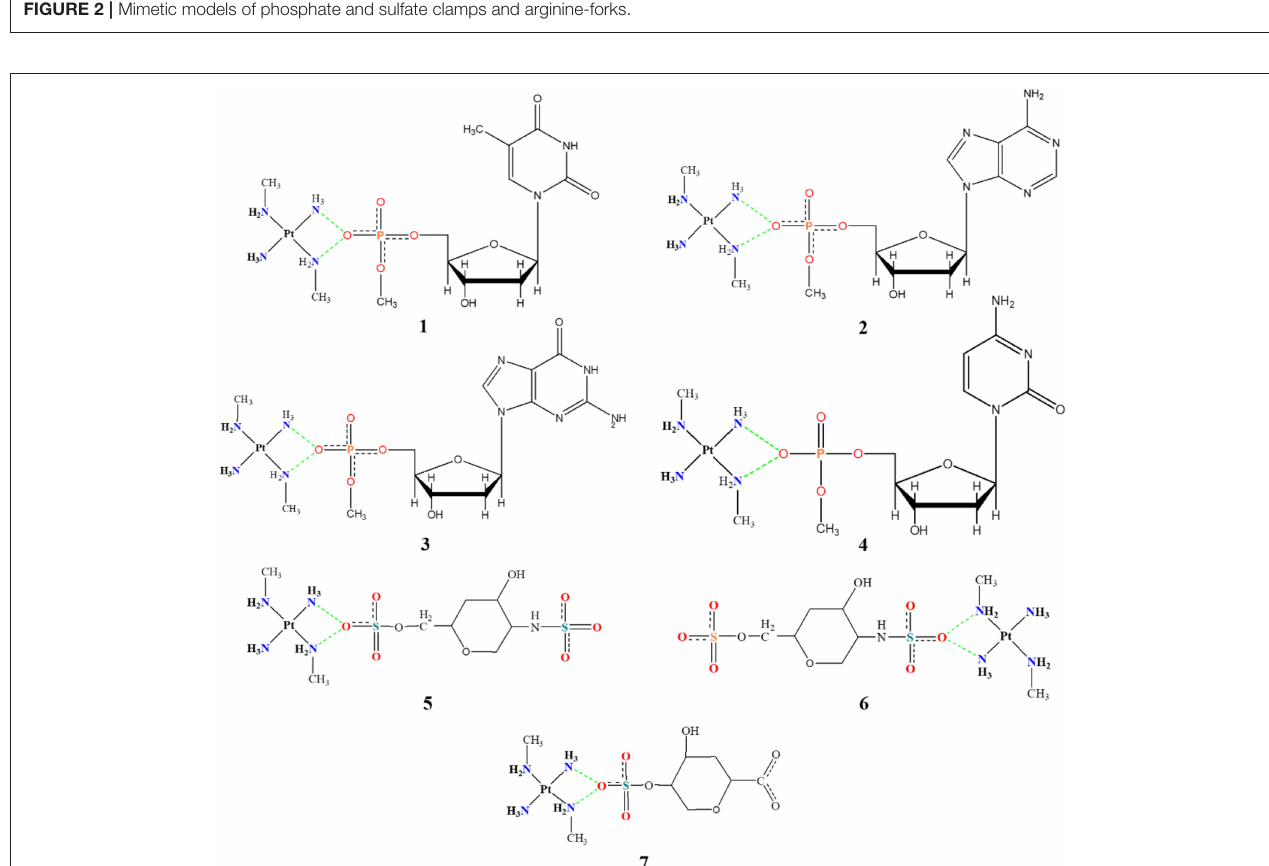
FIGURE 3 | Mimetic models based on nitrogenous bases and fractions of the disaccharide.